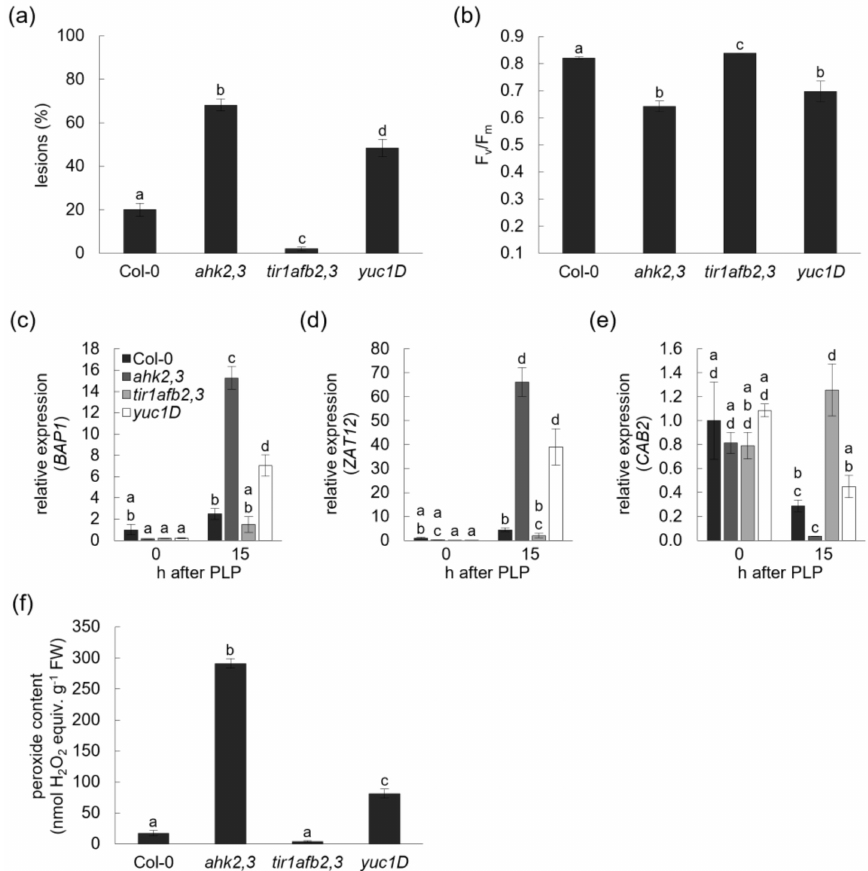
Figure 4. The auxin status influences the response to photoperiod stress. ( a ) Lesion formation of leaves in five-week-old Col-0, ahk2,3 , tir1afb2,3 and yuc1D plants the day after the photoperiod stress treatment. ( b ) Efficiency of photosystem II (F v /F m ) of leaves the day after the photoperiod stress treatment (one-way ANOVA; p ≤ 0.05; n = 15). Transcript abundance of stress marker genes BAP1 ( c ), ZAT12 ( d ) and CAB2 ( e ) 0 and 15 h after the PLP treatment compared to respective control plants. The expression level of wild type at the end of the PLP treatment (0 h) was set to 1 (one-way ANOVA; p ≤ 0.05; n ≥ 3). ( f ) Peroxide content expressed as nmol H 2 O 2 equivalents g − 1 FW in leaves 15 h after PLP treatment (one-way ANOVA; p ≤ 0.05; n = 4). Letters indicate significantly different statistical groups. Error bars indicate SE. Pictures of representative plants exposed to a 24 h prolongation of the light period are shown in Supplementary Figure